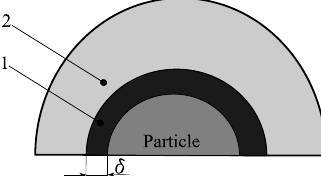
Fig. 1. Homogenisation of a particulate solid where: 1 – matrix film layer; 2 – matrix